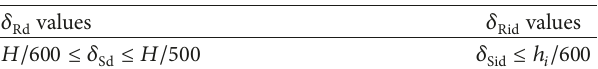
Table 2: Resistant displacements ( 𝛿 Sd is top displacements, 𝛿 Sid is inter-story displacements, 𝐻 is building height, and ℎ 𝑖 is inter-story height). 𝛿 Rd values 𝐻/600 ≤ 𝛿 ≤ 𝐻/500 𝛿 Sd